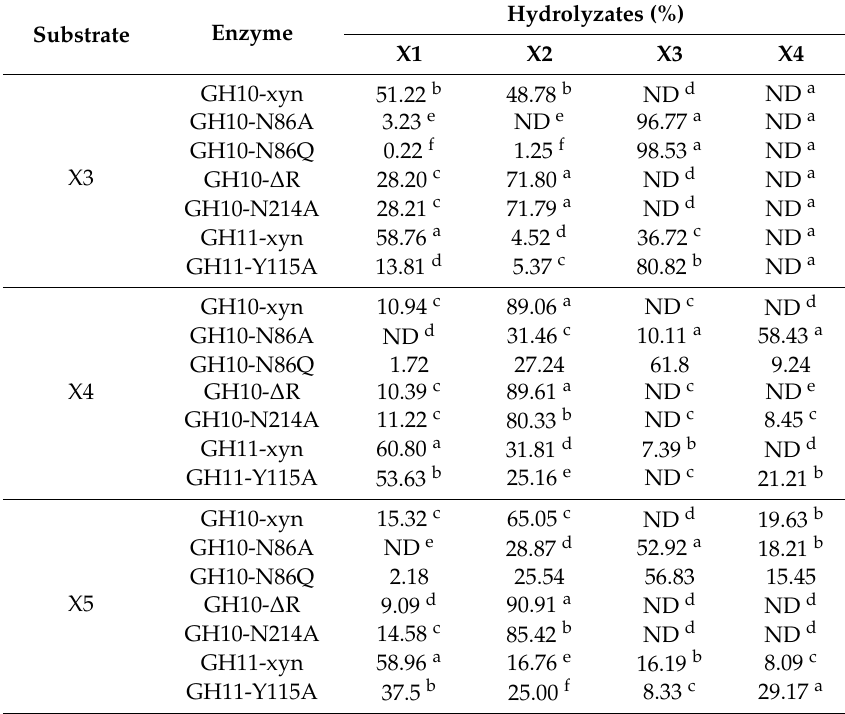
Table 2. Xylooligosaccharides composition in hydrolysis products with xylan substrates (DP = 3–5).